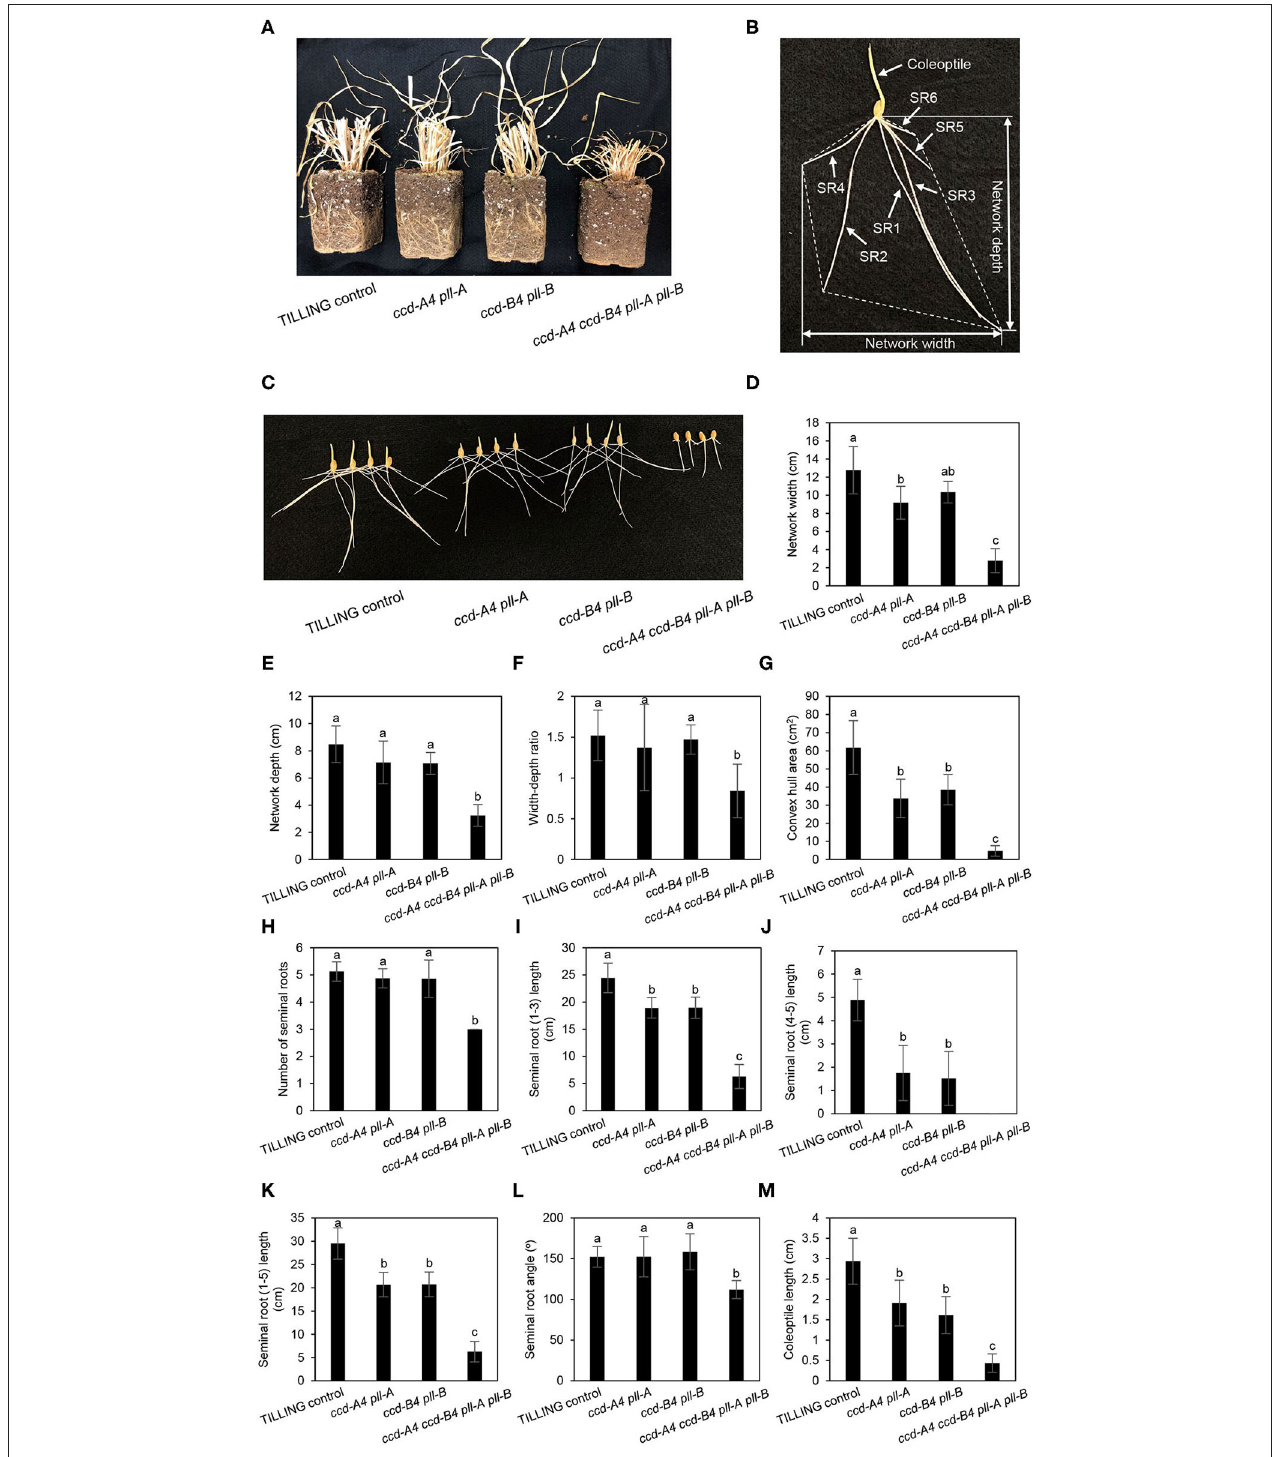
FIGURE 5 | Seminal root phenotyping of TILLING control and mutant seedlings grown in the dark. (A) Overview of root growth for TILLING control and mutant plants at harvest. (B) Diagram showing analysis of wheat seminal root parameters. The convex hull area refers to the smallest area covered by a convex polygon containing the root system and is delineated with dotted lines. SR, seminal root. (C) Image of 3-day-old seedlings grown in the dark. (D–L) Represent different seminal root traits. (M) Coleoptile length. The mean ± standard deviation of 11 seedlings are shown. Different letters denote significantly different ( P < 0.05) for each seminal root trait or coleoptile